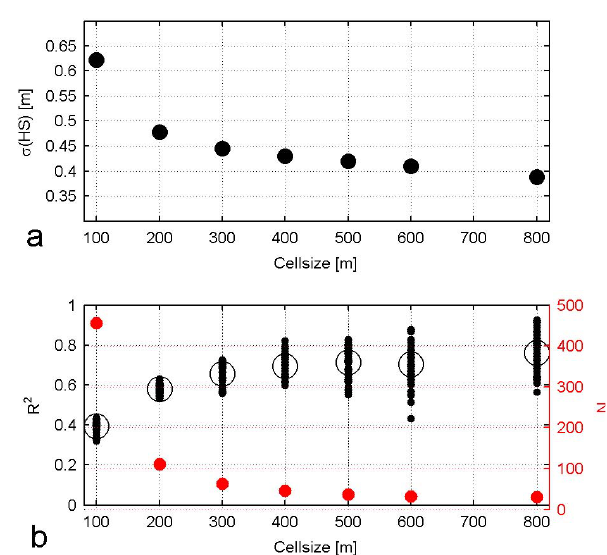
Fig. 5. Relationship between the level of aggregation (cell size) and snow depth variability expressed by (a) the standard deviation σ (HS), and (b) model performance ( R 2 ) for the Wannengrat area (model with d E , SL, NO). The black circles indicate the mean of 50 random model runs. The R 2 of each run is induced by a small black dot. The red dots show the average number of sub-areas ( N ) at each aggregation